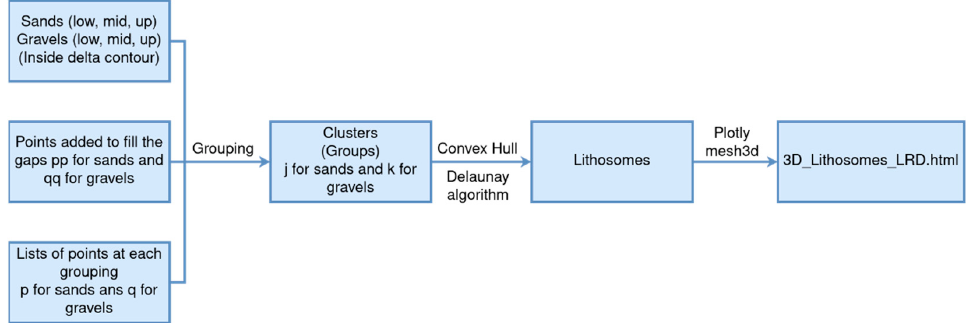
Figure 6. Flow diagram showing the 3D stratigraphic architecture mapping stage.